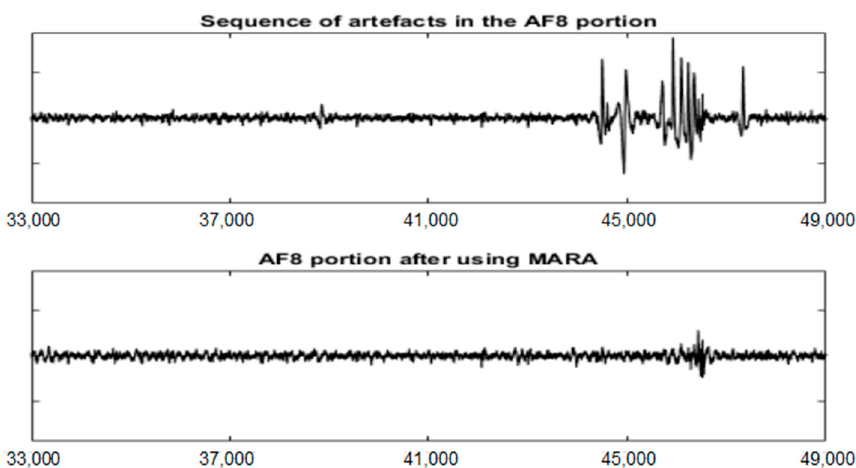
Figure 12. The EEG portion [33,000 49,000] of the AF8 channel before and after using the MARA method.